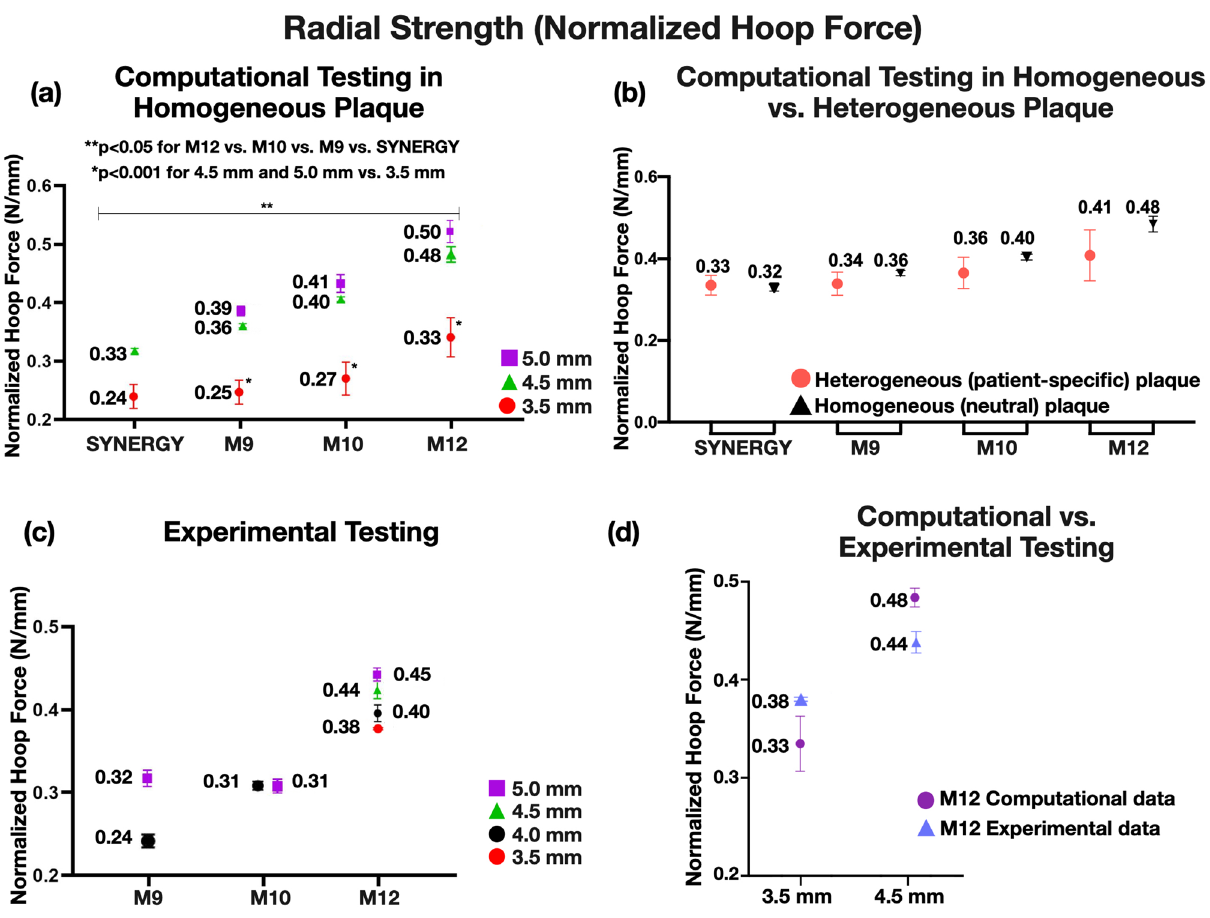
Figure 8. Normalized hoop force of MEGATRON and SYNERGY stent designs expanded at different diameters. ( a ) Normalized hoop force calculated computationally across different stent designs and expansion diameters for homogeneous plaque material, ( b ) Normalized hoop force calculated computationally across different stent designs for heterogeneous plaque material, ( c ) Normalized hoop force calculated experimentally across different stent designs and expansion diameters, ( d ) Computational vs. experimental normalized hoop force of 12-peak MEGATRON; M12: MEGATRON 12-peak, M10: MEGATRON 10-peak, M9: MEGATRON